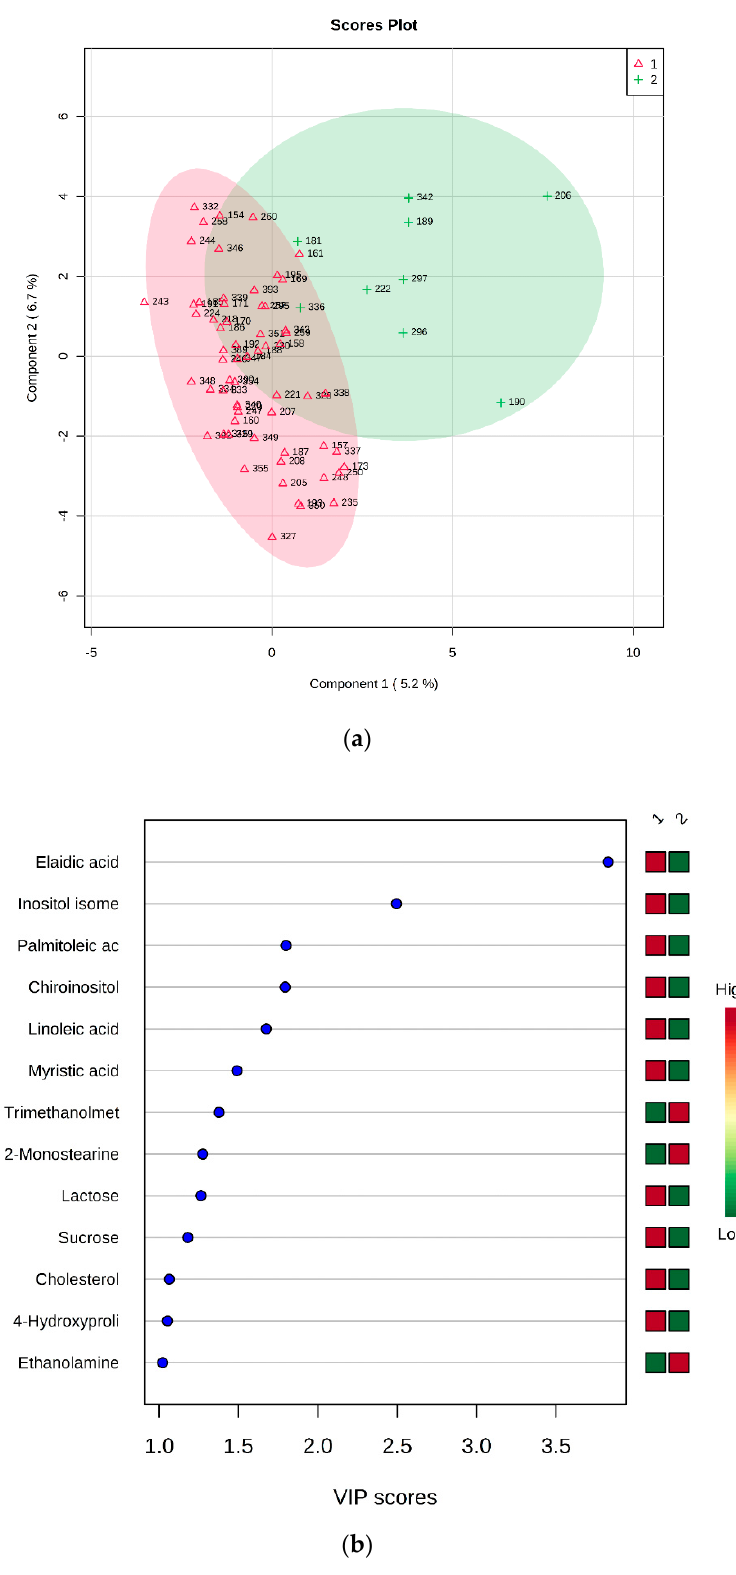
Figure 4. PLS-DA analysis of WT + HZ (group 1) vs KO (group 2). ( a ) 2D scores plot, and ( b ) the corresponding VIP score plot (score > 1.0).